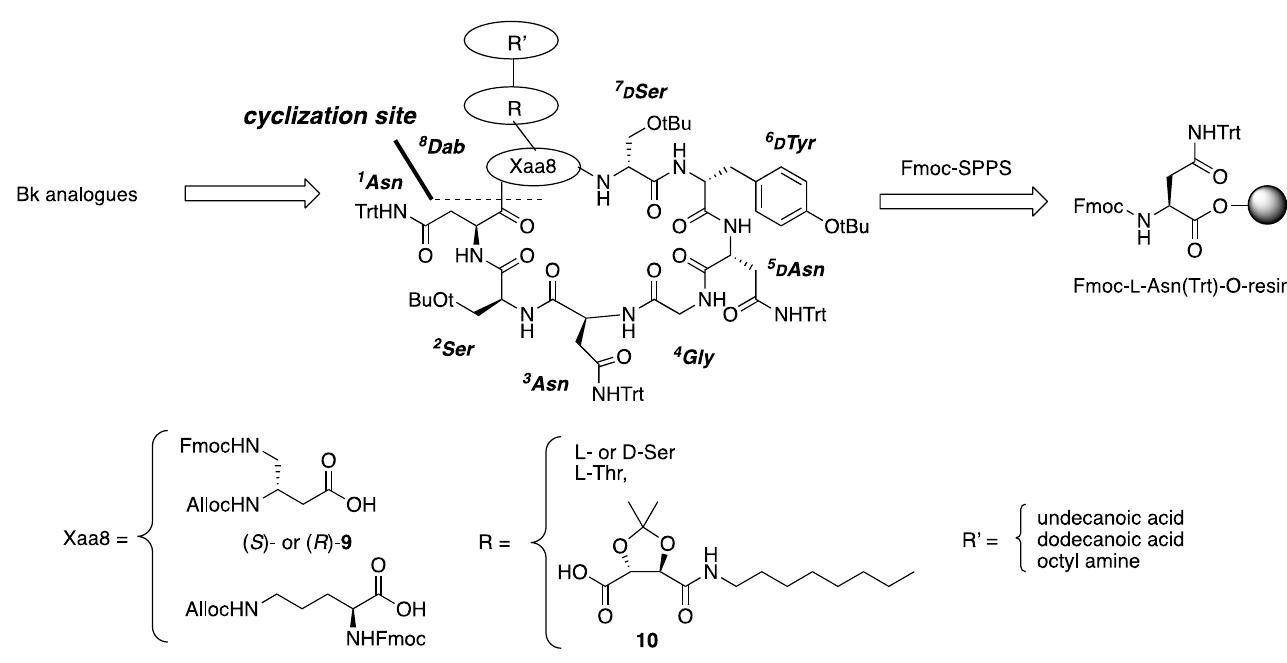
Scheme 1. Synthesis of burkholdine analogues.